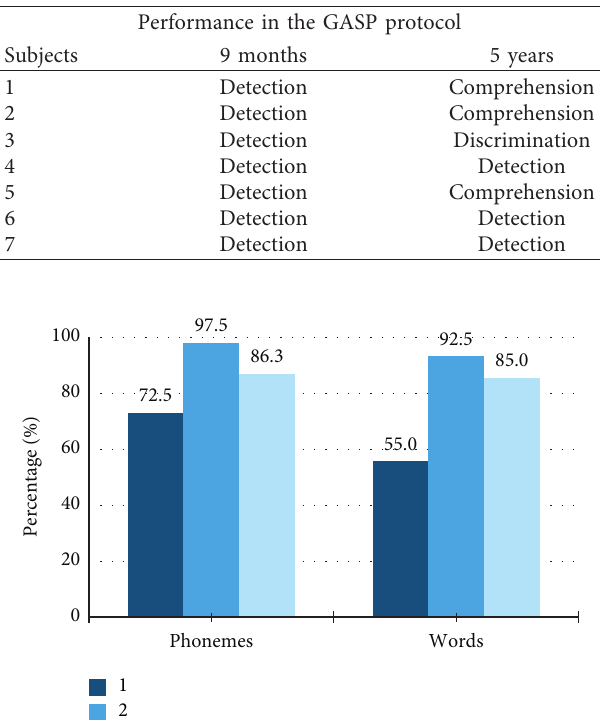
Table 3: Result of the auditory skills obtained through the GASP